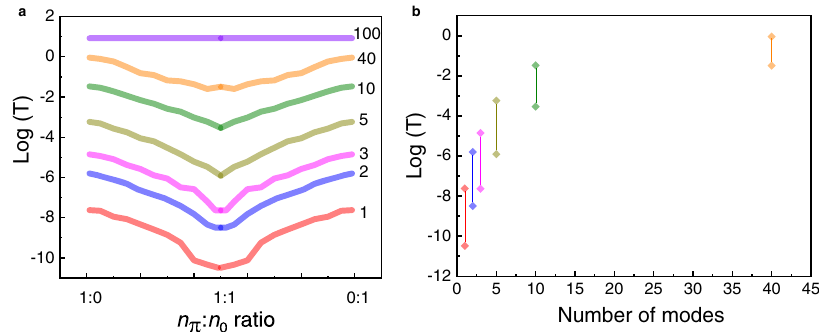
Fig.6|Theeffectofphaserandomizationandthenumberoftransversemodes onthetransportpropertiesofMEJs.a Calculatedtransmissionforjunctionswith the indicated number of conductance modes as a function of the phase ratio. The conductance of pure π and pure 0 phases, are identical. b The range of